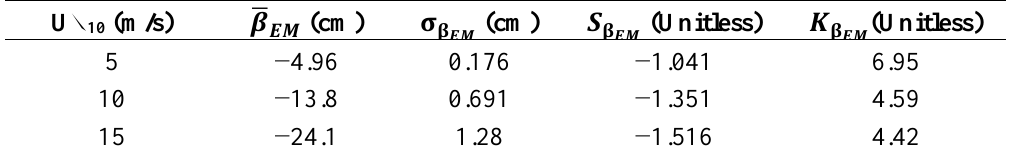
Table 3. EM bias time series main statistical descriptors for incidence/scattering θ = θ = 45°, wind direction φ = 45°, and U i s R R R R